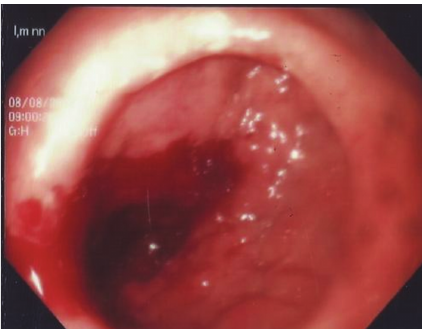
Figure 1: Esophagogastroduodenoscopy findings of the patient: a tight stricture with mucosal edema and the longitudinal ulcerations in the duodenal bulb with a near-complete obstruction.